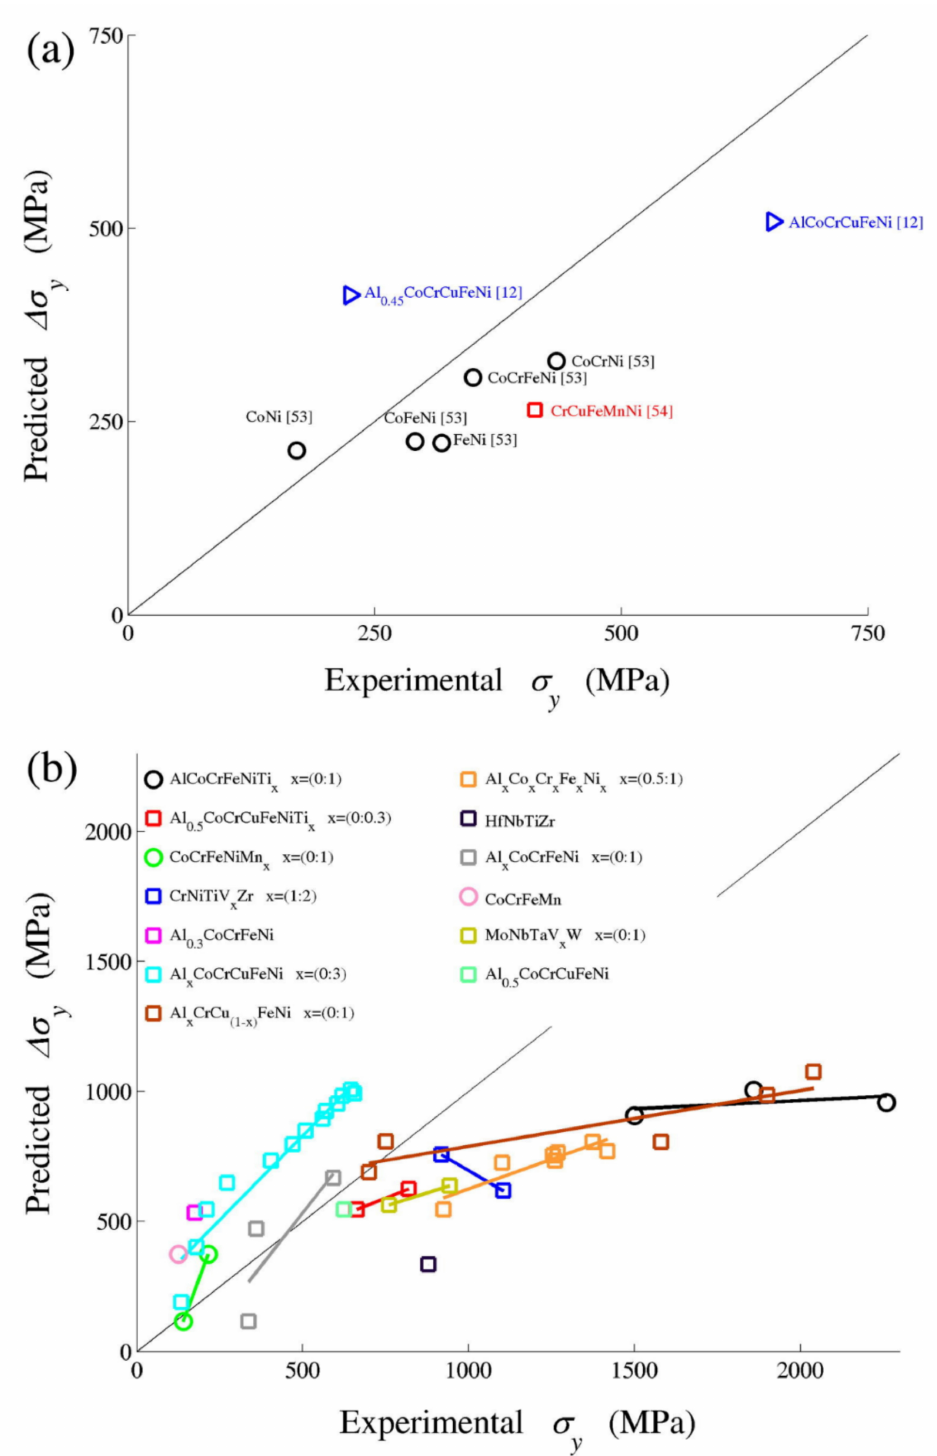
Figure 6. Predicted yield strength as a function of experimental yield strength from solid solution strengthening. Adapted from